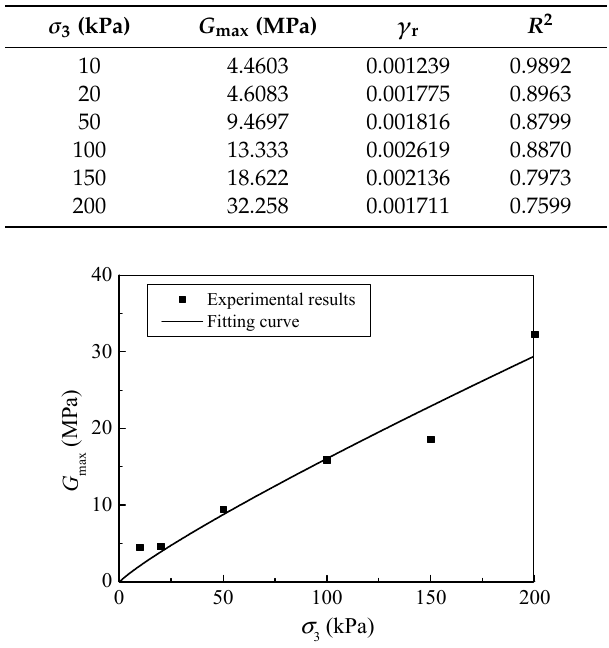
Figure 9. Maximum shear modulus versus confining pressures.